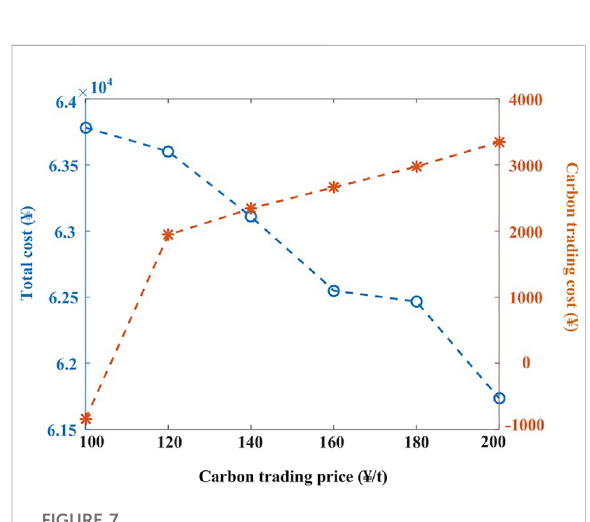
FIGURE 7 Relation curve between total cost, carbon trading cost and carbon trading price.